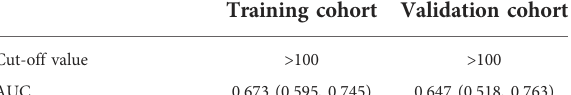
TABLE 3 The prediction performance of nomogram model in training and validation cohorts.